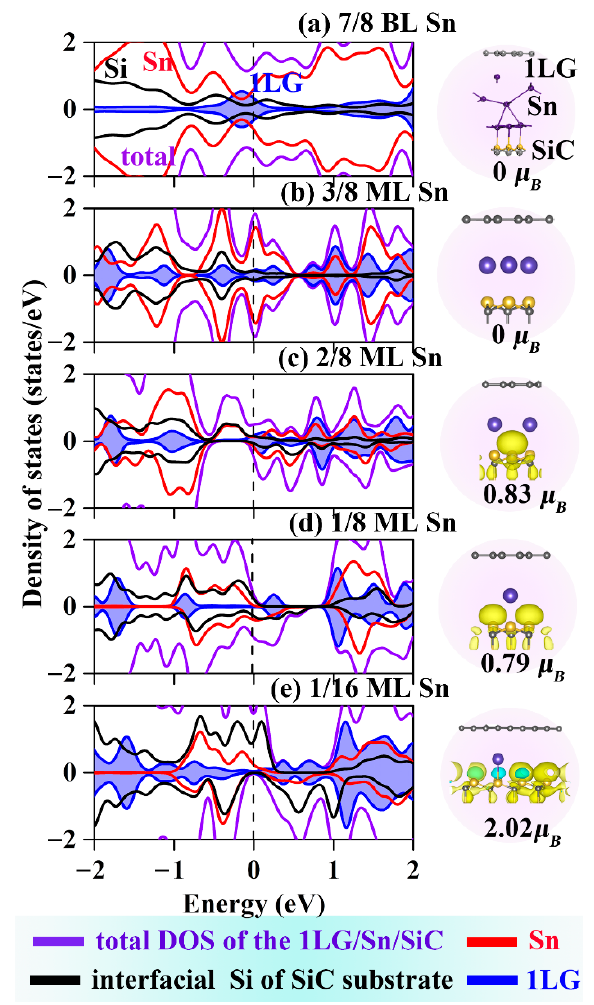
Figure 4 . DOSs and spin densities for ( a – e ) 1LG/Sn/SiC with different coverages. Light blue and yellow isosurfaces represent positive and negative spin densities (±0.02 e/Å3), respectively. The purple lines represent the 1LG/Sn/SiC. The black, red, and blue lines correspond to the PDOS of interfacial Si of SiC substrate, Sn and 1LG, respectively.